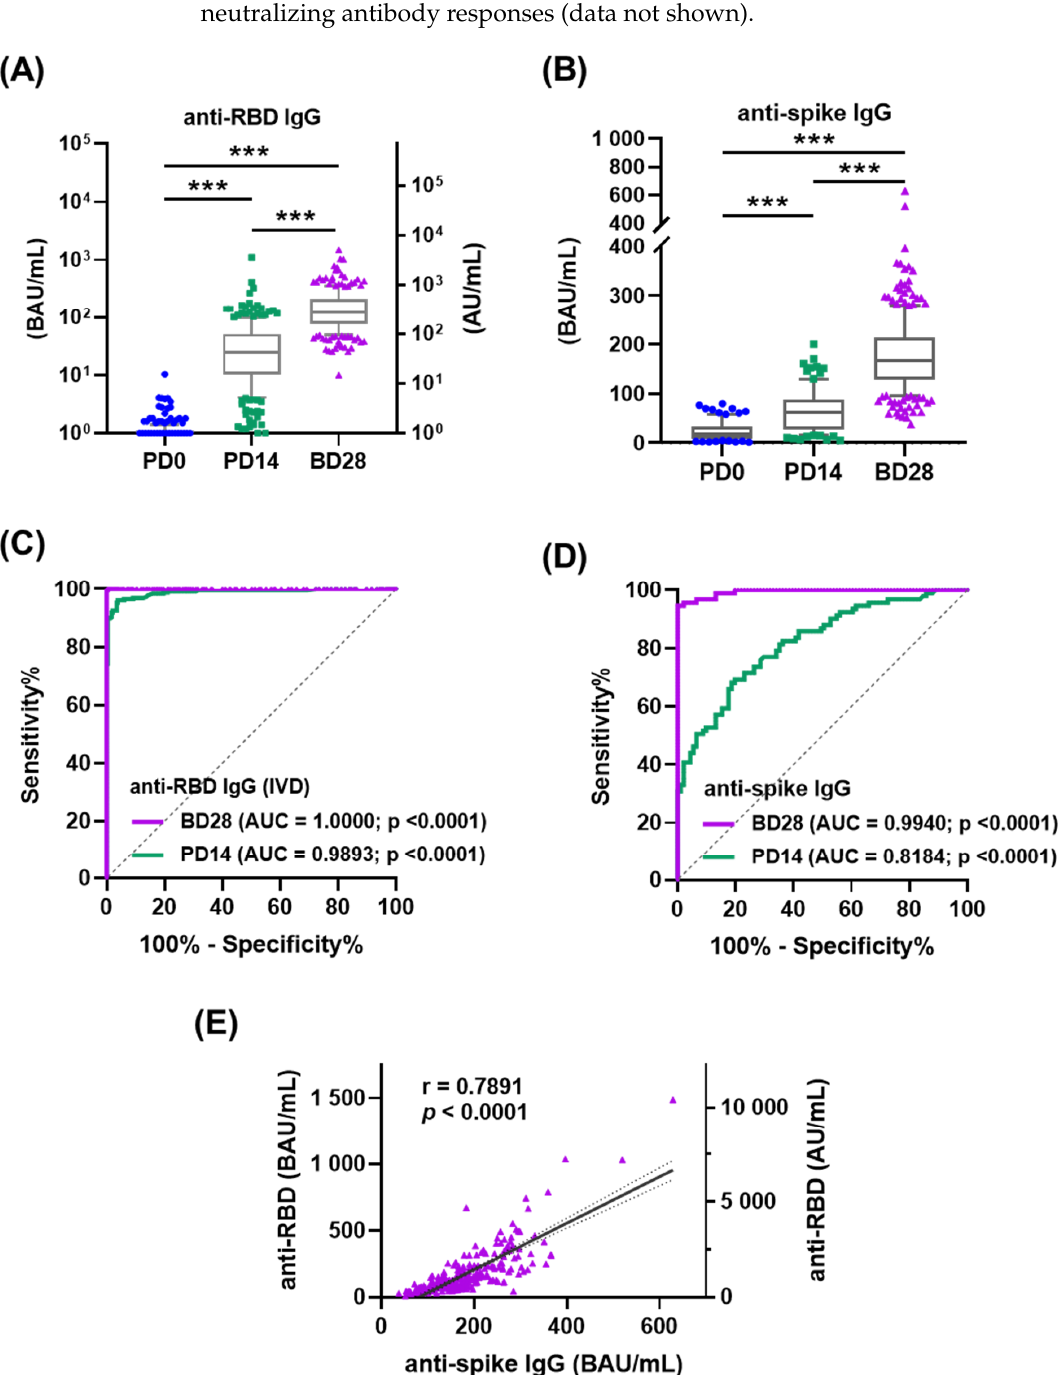
Figure 1. Antibody responses in ChAdOx1 nCoV-19 vaccinated recipients without previous COVID-19. Participant serum samples were collected at PD0, PD14, and BD28. PD0: day 0 before the prime vaccination; PD14: 14 days after the prime vaccination; BD28: 28 days after the boost vaccination. ( A , B ) Anti-spike RBD ( C ) and anti-spike ( D ) IgG levels were measured before and after vaccination. AU: arbitrary units; BAU: binding antibody units. ( C , D ) Receiver operating curves (ROC) for anti-RBD ( A ) and anti-spike ( B ) IgG were analyzed to assess the predicted seropositivity after vaccination. ( E ) Linear regression analysis was performed to show the correlation of anti-spike RBD and anti-spike IgG. *** p < 0.001